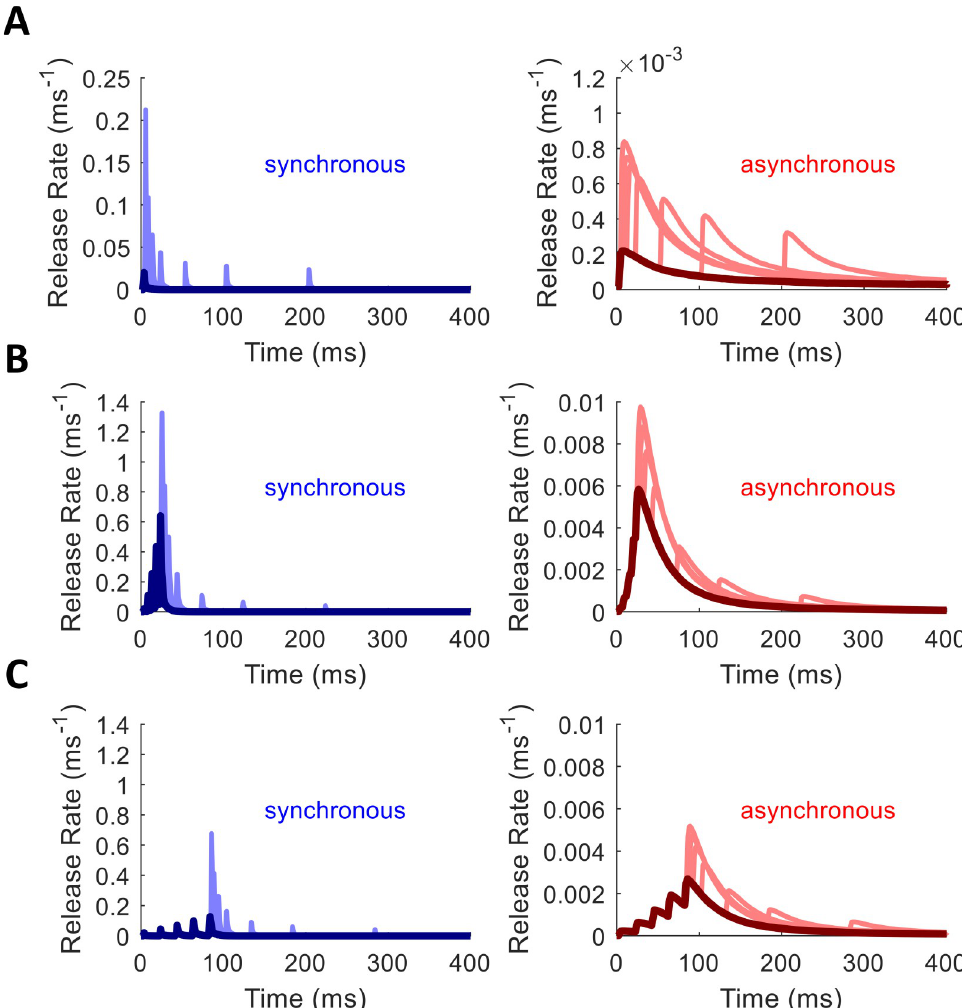
Fig 9. Empirical Facilitation in Synchronous and Asynchronous Release Rates. Release rate profiles facilitate in response to single spikes (A) or to spike ramps (B,C). Probe spikes of increasing ISI reveal how facilitation then decays back toward baseline after a delay. Each rise in release rate is triggered by a spike event. Synchronous release rate profiles shown in blue. Asynchronous profiles shown in red. Profiles from multiple runs are overlaid in each panel. Dark colors represent response to initial spike or spike ramp (common to all traces on a plot). Light colors represent profiles from different runs in response to single probe spikes at different ISIs following the initial spike or ramp. (A) After single spike, paired-pulse facilitation decays with increasing ISI (probe ISIs of 2, 5, 10, 20, 50, 100, 200 ms). (B) 5-spike ramp with a 5-ms ISI shows strong facilitation in release rate (dark colors) followed by rapid decay seen at the probe spikes (light colors). (C) 5-spike ramp with a 20-ms ISI shows weaker facilitation in the ramp phase but a similar rate of decay at the probe spikes. Note the orders of magnitude difference in scale between synchronous and asynchronous release rates, as well as the change in scale from (A) to